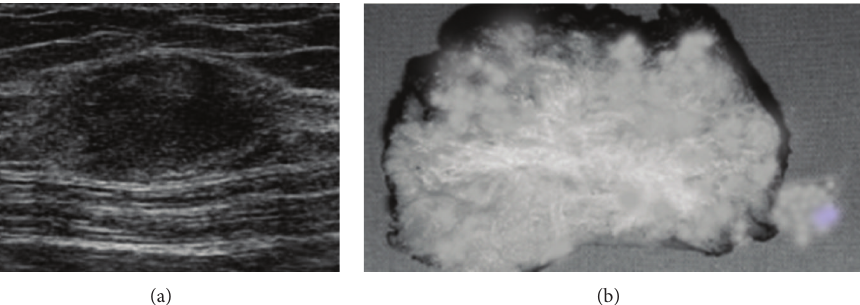
Figure 1: (a) USG in the transverse plane showing echogenic subcutaneous mass. (b) Gross photograph showing grey-white fibrous area with tiny cysts in the subcutaneous fat.